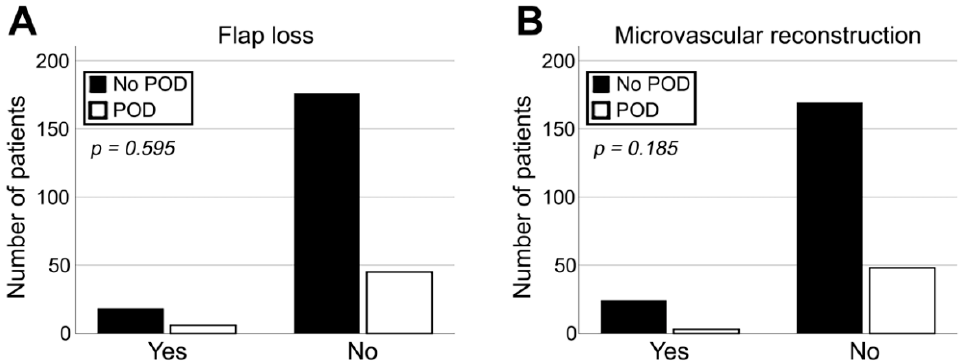
Figure 3. Impact of diagnosis of POD on occurrence of flap loss ( A ) and association between type of reconstruction and incidence of POD ( B ).